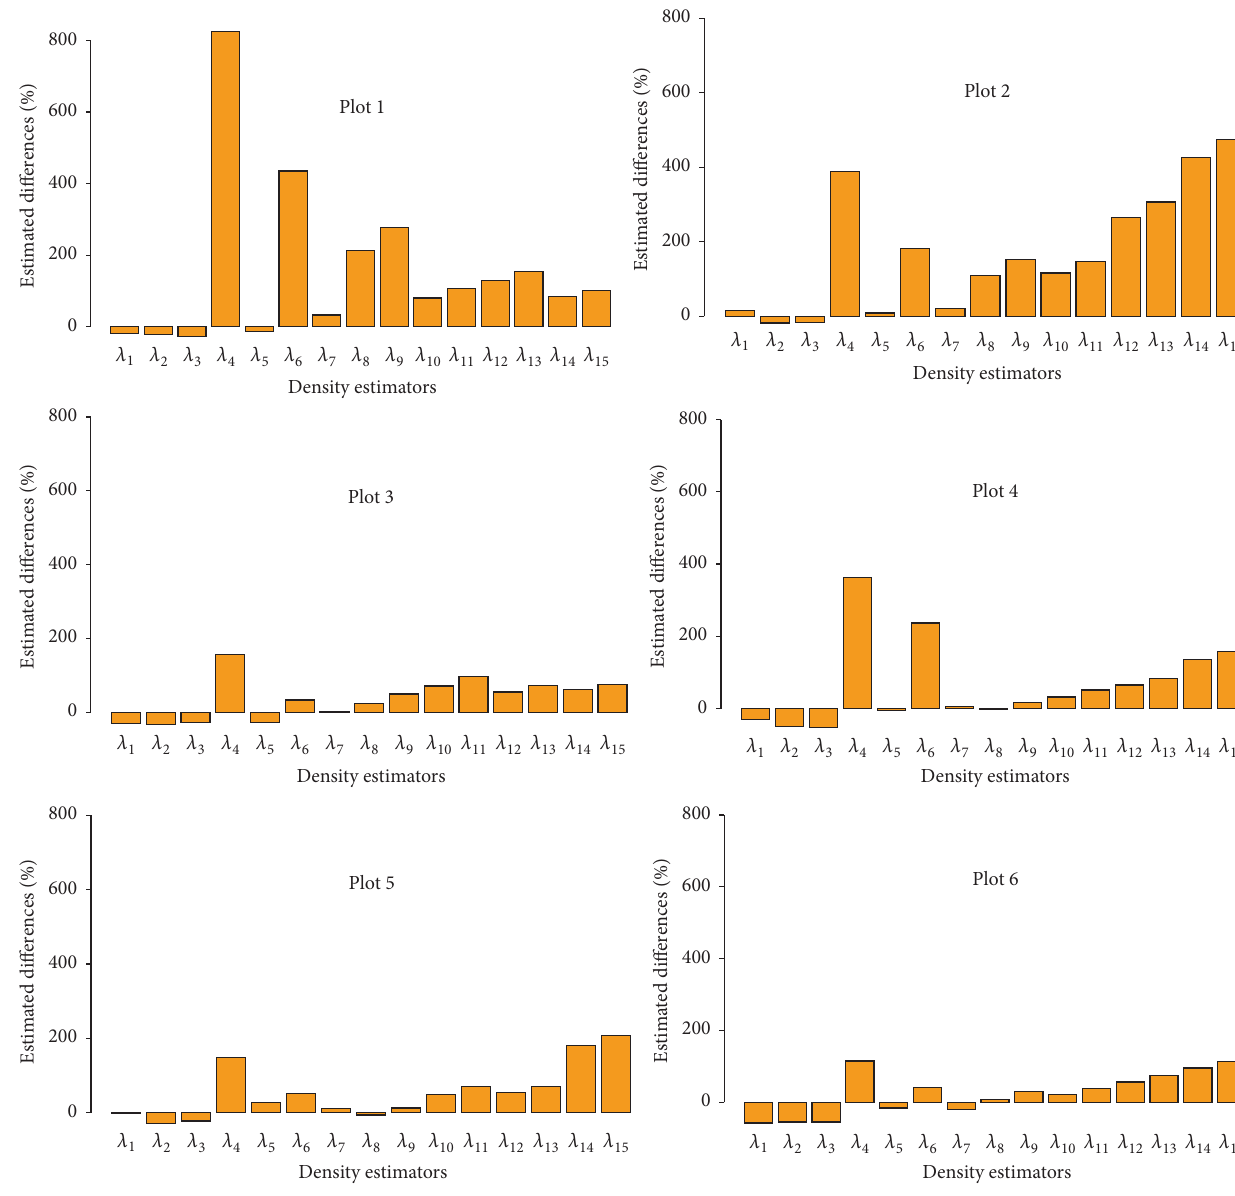
Figure 4: Comparison of distance methods and respective estimators ( 𝑇 -Square, 𝜆 1 – 𝜆 4 ; PCQM, 𝜆 5 – 𝜆 7 ; 𝑁 -tree, 𝜆 8 – 𝜆 15 ) with quadrat counts, for tree density estimates in all six Pittosporum undulatum stands. The bars represent the estimated relative difference between each distance method and the estimated tree density using quadrat counts, as obtained from contrast analysis applied after ANOVA (divided by tree density estimated by quadrat counts and expressed as a percentage). Table 4: Summary of the analysis performed regarding the spatial distribution patterns in the six plots sampled at Pittosporum undulatum stands. Significant deviations from a random pattern are indicated in bold (aggregated) or in italic (regular). 𝑇 -Square PCQM Quadrats Plots